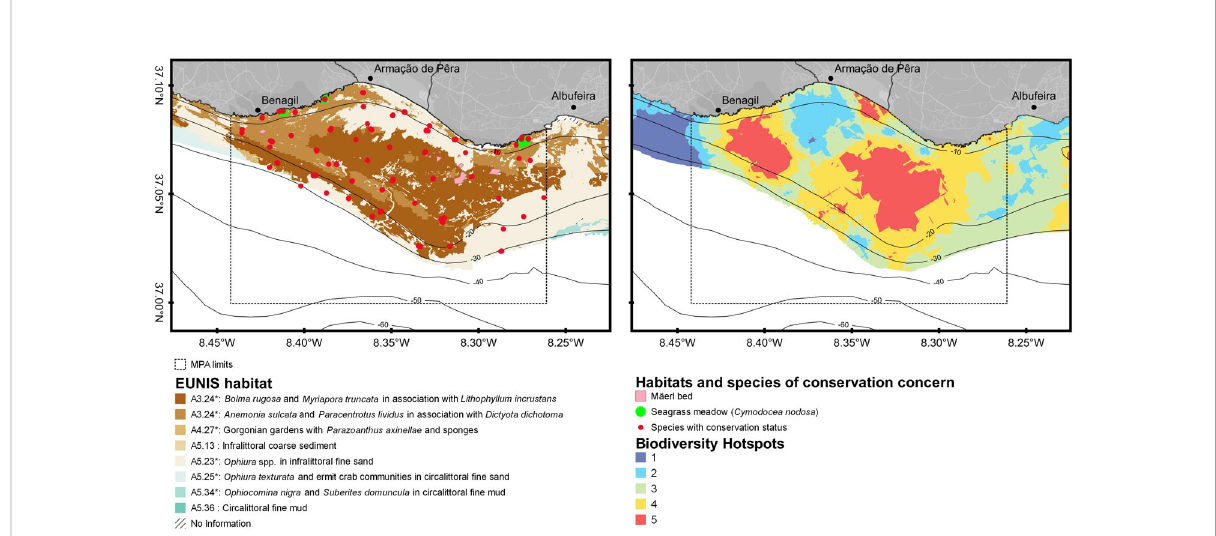
FIGURE 3 Maps of biotic habitats and natural values in the region of the future MPA (adapted from Gonc ̧ alves et al., 2016 and Sales Henriques et al., 2018): EUNIS habitats with vital ecological functions (include mixed gorgonian and sponge gardens, seagrass meadows, mäerl beds, also included in the OSPAR Convention) and species with conservation status (include the most threatened categories of the IUCN red list and Bern Convention/Habitats Directive; see Table S1, Supplementary Materials) – left panel; multi-component biodiversity index with fi ve standardized levels (from 1 – the lowest, to 5 – the highest value), in which level 5 is considered a biodiversity hotspot – right panel. *New level 5 EUNIS habitats described for the Portuguese coast awaiting the de fi nitive